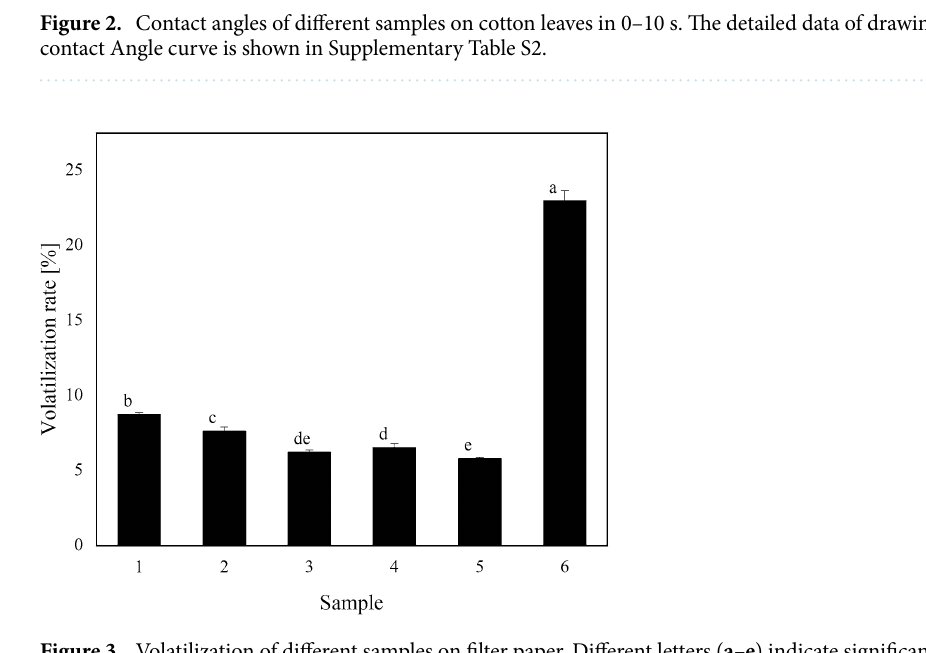
Figure 3. Volatilization of different samples on filter paper. Different letters ( a–e ) indicate significant differences between means. Means followed by the same letter are not significant at the 5% significance level by the LSD test (LSD = 0.05). Vertical bars indicate a standard deviation of the mean. The detailed data of the histogram is shown in Supplementary Table